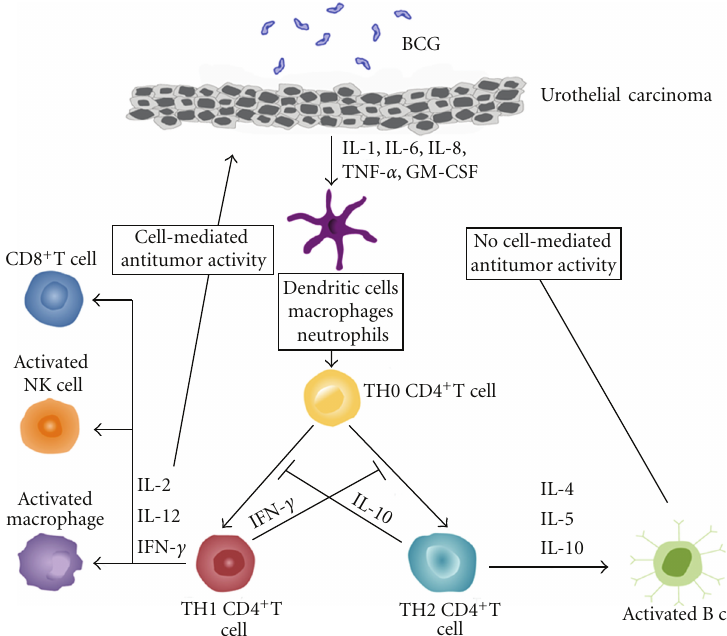
Figure 1: Suggested cascade of immune responses in bladder mucosa induced by intravesical BCG instillation. Attachment of BCG to urothelial cells including carcinoma cells triggers release of cytokines and chemokines from these cells, resulting in recruitment of various types of immune cells into the bladder wall. Activation of phagocytes and the new cytokine environment lead to the di ff erentiation of na¨ıve CD4 + T cells into TH1 and/or TH2 cells that direct immune responses toward cellular or humoral immunity, respectively. The therapeutic e ff ect of BCG depends on a proper induction of TH1 immune responses. IL-10 inhibits TH1 immune responses, whereas IFN- γ inhibits TH2 immune responses. Blocking IL-10 or inducing IFN- γ can lead to a TH1-dominated immunity that is essential for BCG-mediated bladder cancer